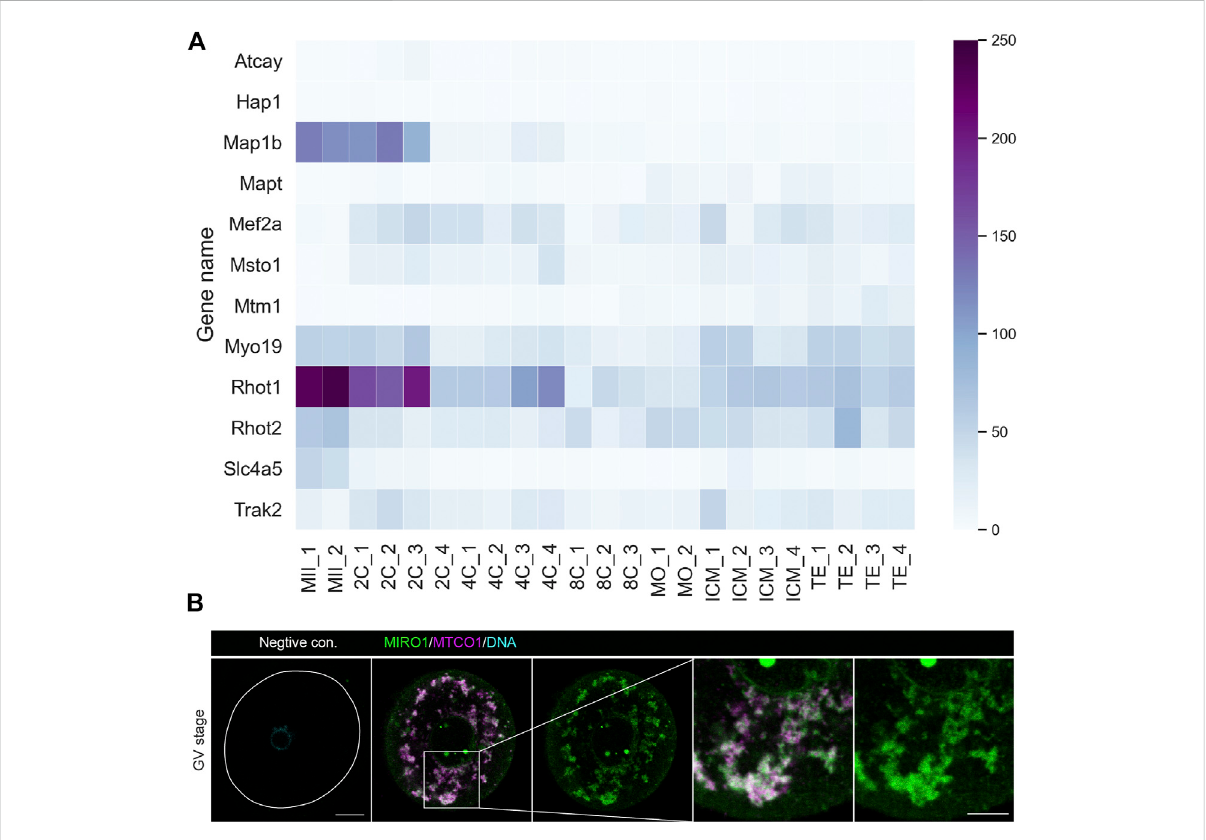
FIGURE 1 MIRO1 protein localization in mitochondria of mouse oocytes . (A) A heatmap of the expression levels of transcripts related to mitochondrial transport genes. Results are in transcripts per million (TPM) with blue range colors. (B) Representative images of the localization of MIRO1 in a fully grown GV-stage oocyte. Green: MIRO1, Magenta: MTCO1, Cyan: Hoechst 33342. Scale bar: 15 µm in whole oocytes and 10 µm in cropped